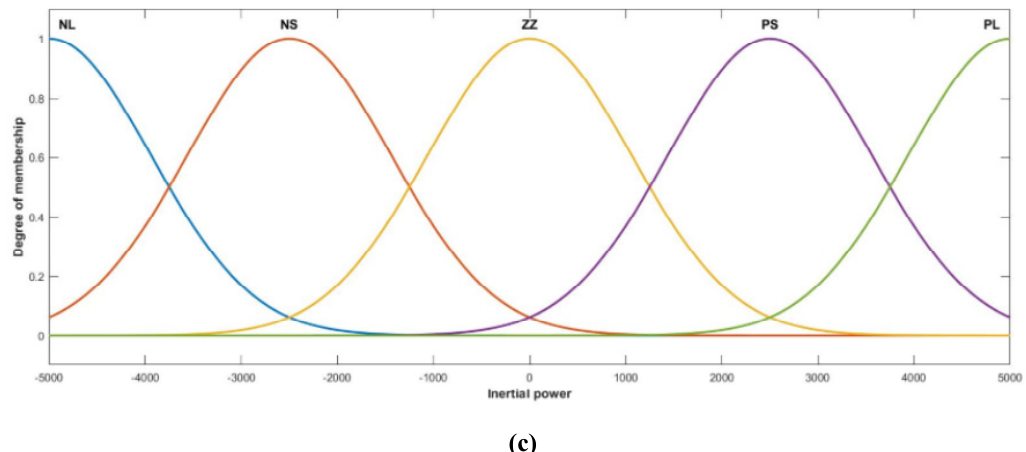
Figure 7. Membership function of ( a ) frequency deviation; ( b ) ROCOF; ( c ) Inertial power. Initially, fuzzification is utilized to transform actual inputs into fuzzy values. Table 2 summarizes the properties of input and output membership functions. The mean of the membership is defined as the range of inputs/outputs to several partitions (number of partitions = number of membership functions − 1). Table 2. Properties of frequency deviation, ROCOF and inertial power membership functions. Membership